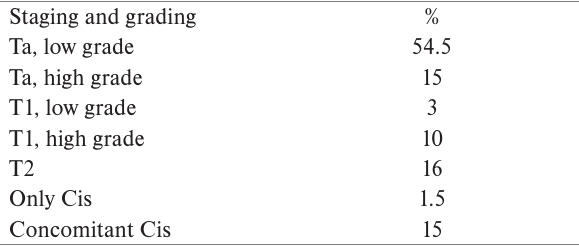
Table 2. Staging and grading of urothelial carcinoma (n=68).